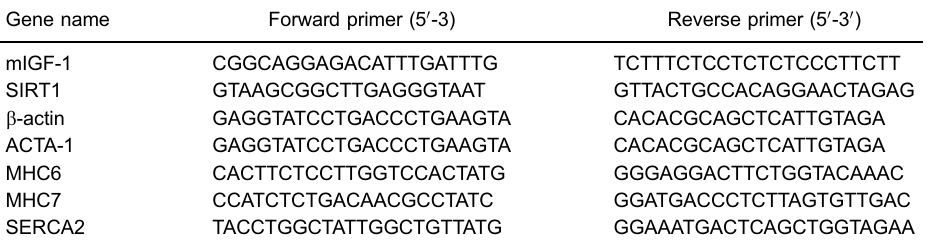
Table 1. Sequences of all primer pairs in the